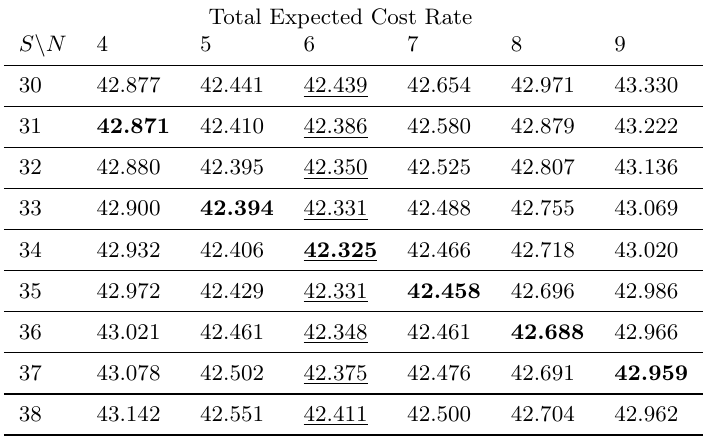
Table 1: Total expected cost rate as a function of S and N